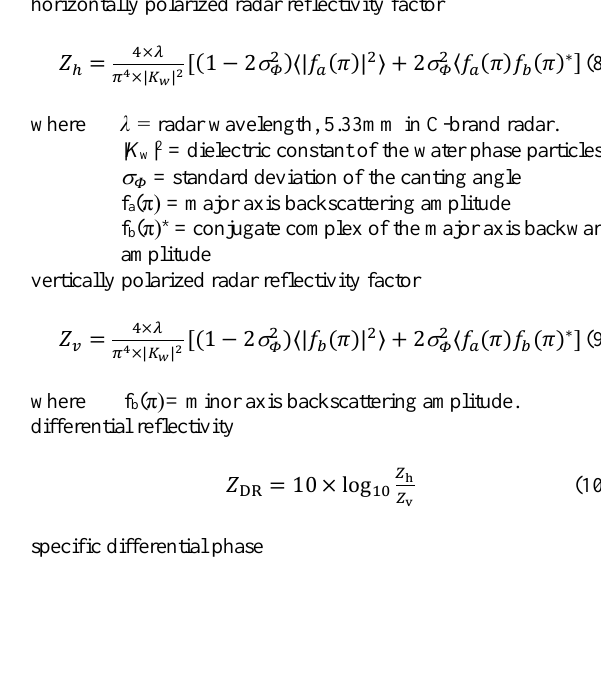
velocity, and on the right side of the x-axis, a small number of particles larger than 8